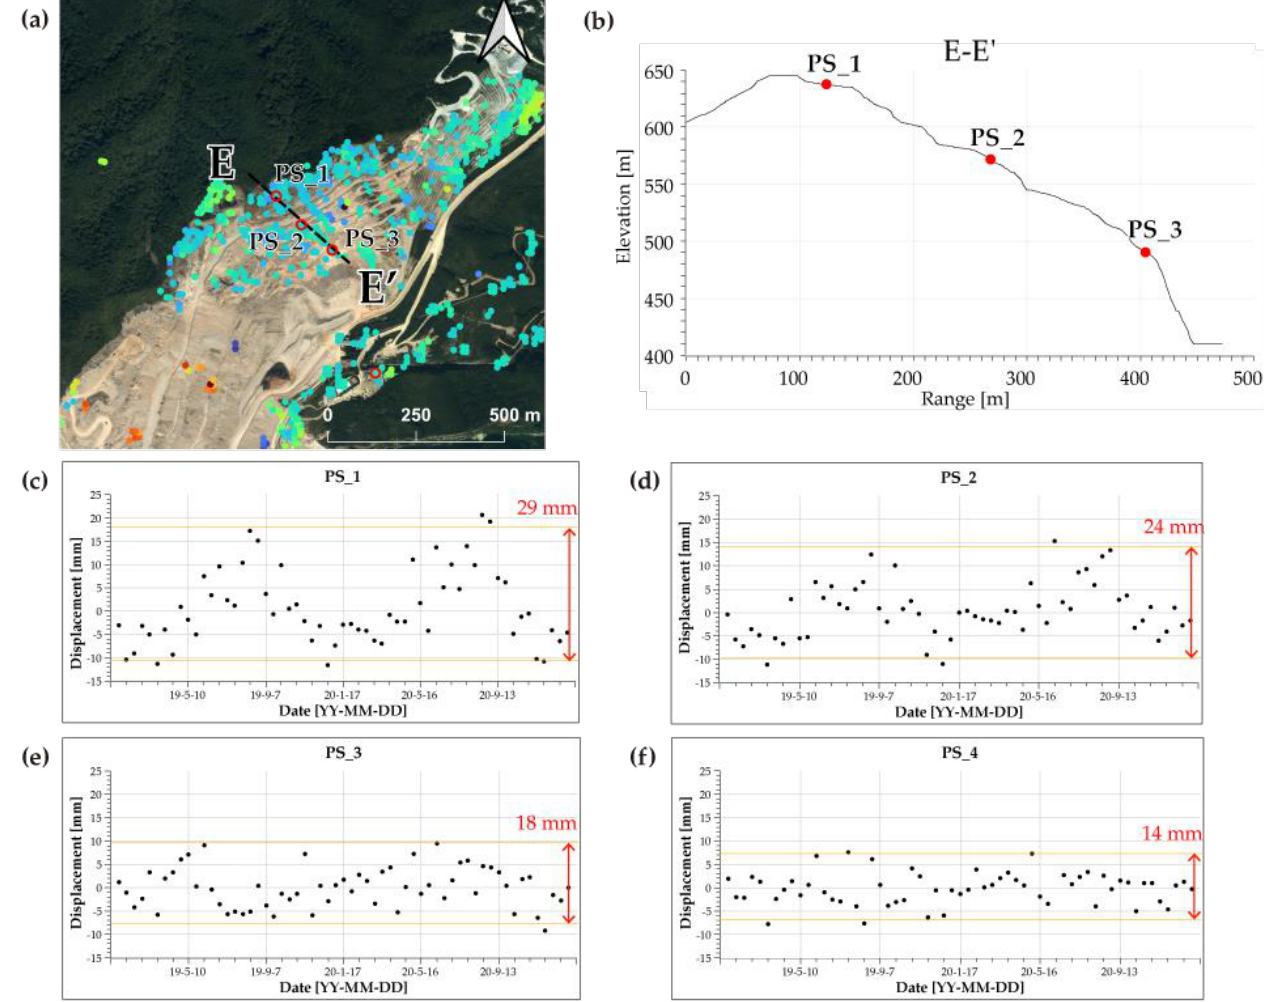
Figure 12. Seasonal LOS displacement trend in a time-series plot of PS_1, PS_2, and PS_3 from the PSInSAR images. ( a ) PSInSAR result in limestone rock, ( b ) a profile of E-E’ with Copernicus DEM, time-series plots of displacement in the ( c ) PS_1, ( d ) PS_2, ( e ) PS_3, and ( f ) PS_4. PS_4 is selected at the lower point in a valley for comparison.